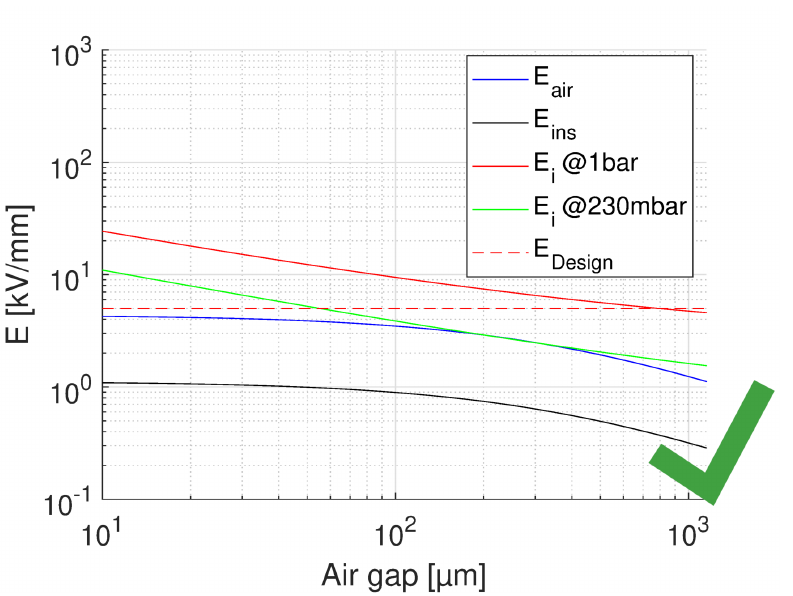
Figure 14. Feasibility plot for the design of slot insulation, with the insulation thickness (H2 = 1150 µ m) providing no PD for any air gap and considered pressure range. Test voltage = 1287 V (Figure 2, Table 1). The x axis reports the air gap